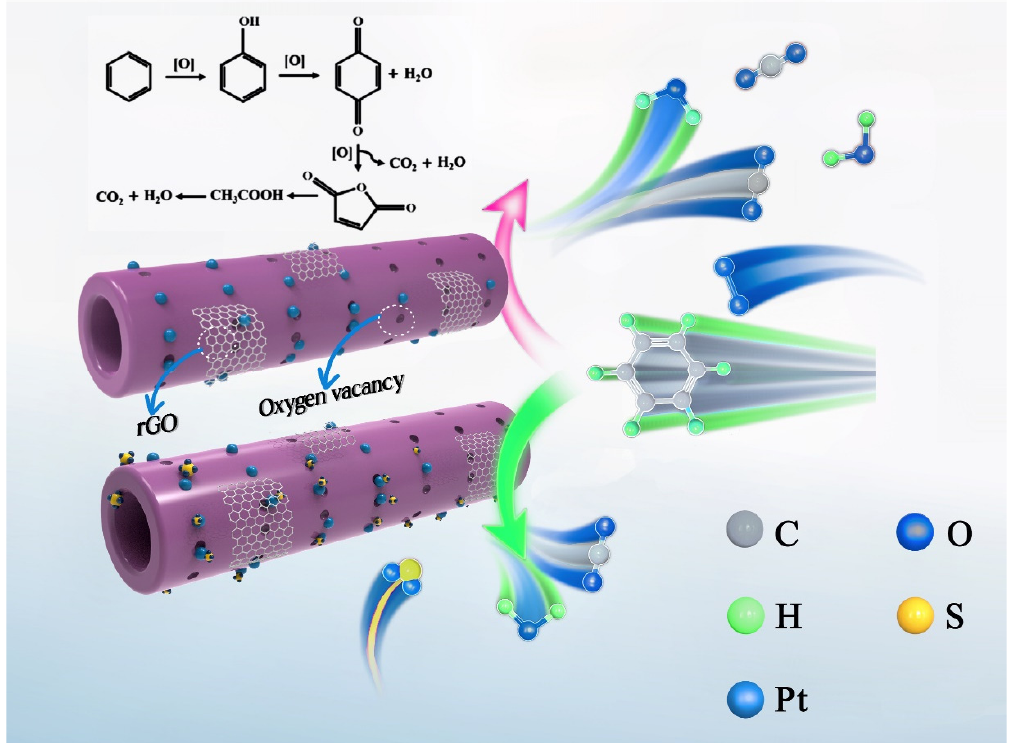
Figure 11. Proposed catalytic mechanism of benzene oxidation over 0.94Pt-1.0rGO/ α -MnO 2 .